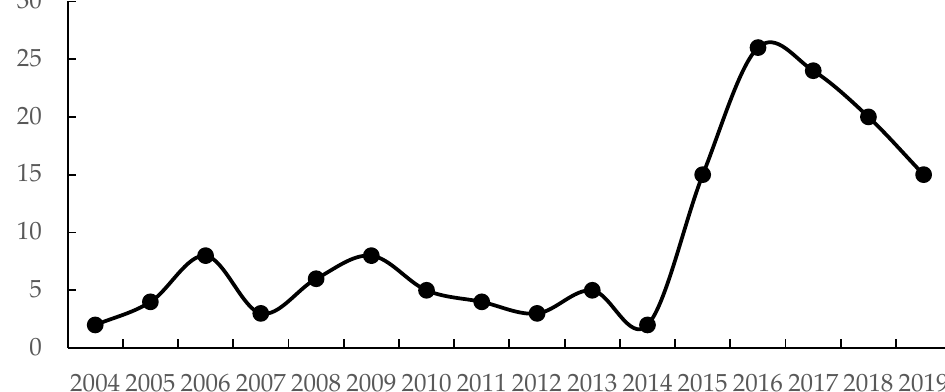
Figure 8. Number of provinces included in category SD during the study period.